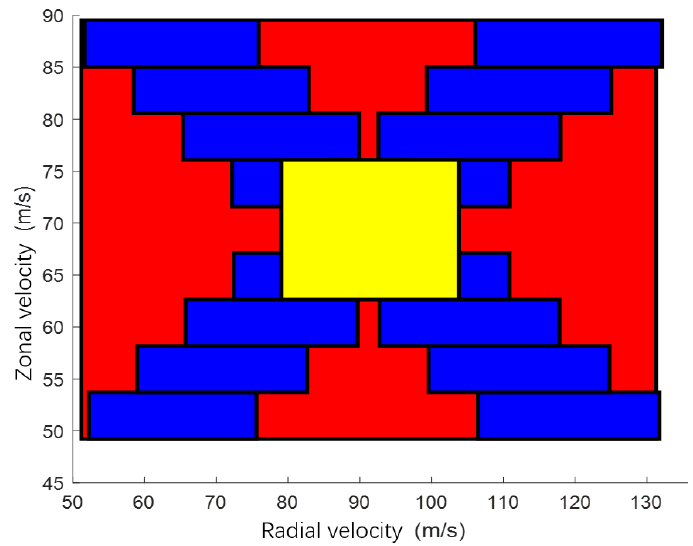
Figure 3. The result of the first iteration of the algorithm.